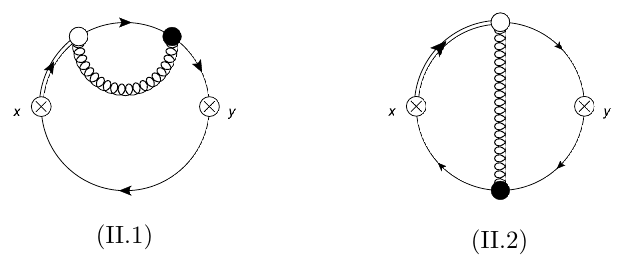
Figure 5. Type II diagrams for the evolved 2-point vector correlator at O ( g 2